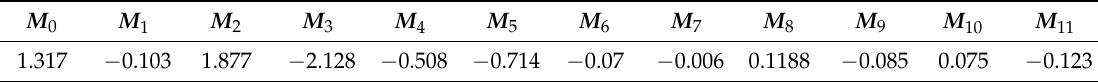
. ε * ( c ).       ln / T T T T   ( b ) and ln ε *  ( c ). m m r . ε * (cid:1) (cid:0) ε ,ln (( T m − T ) / ( T m − T r )) ,ln .